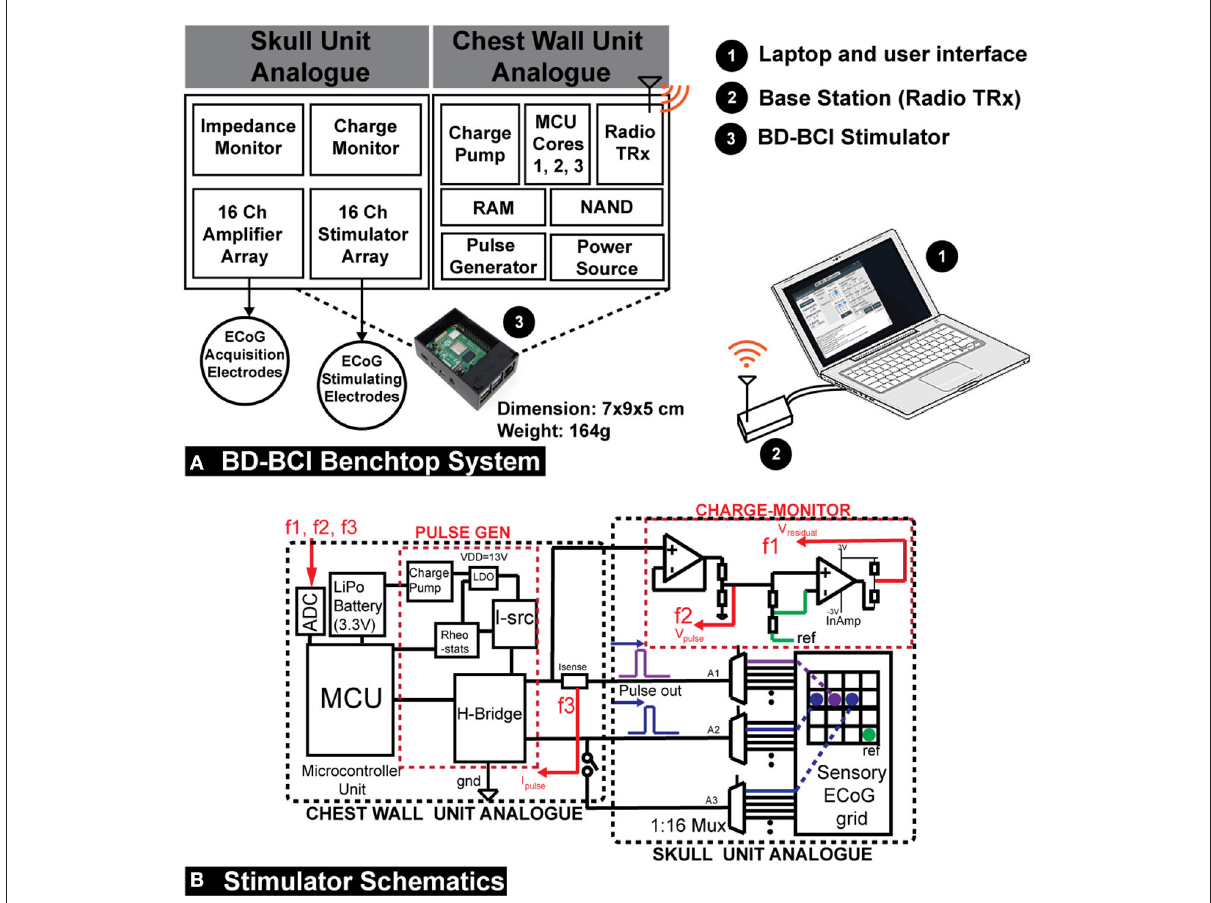
FIGURE2 (A) A diagram of the operation of the prototype implantable BD-BCI stimulator. Compressing the structure of the envisioned fully implantable BCI system on a custom printed circuit board, the CWU analog supplies electrical pulse trains to the SU analog which has a